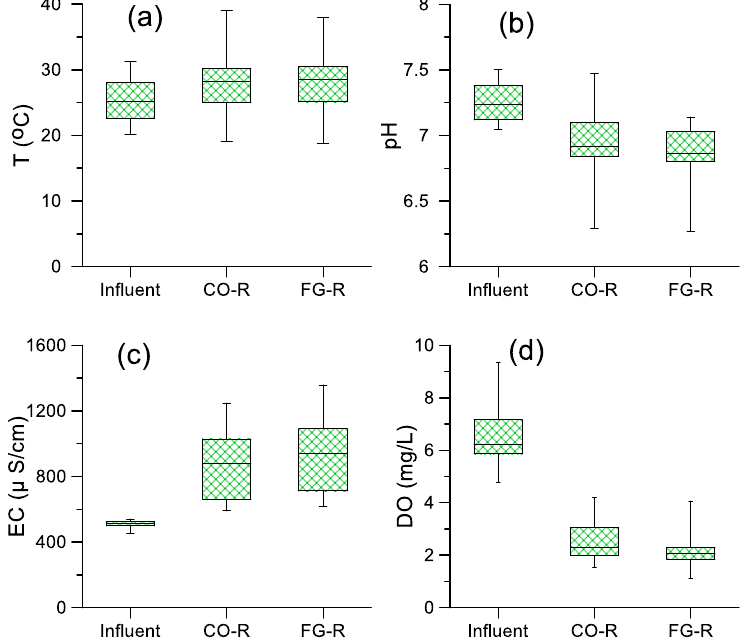
Figure 2. Box – whisker plots of physicochemical parameters in the CWs units: ( a ) temperature; ( b ) pH; ( c ) electrical conductivity; ( d ) dissolved oxygen. The line inside the box denotes median values, the upper and lower box frames denote the 75 and the 25 percentiles, respectively, and the whiskers denote the maximum and minimum values.